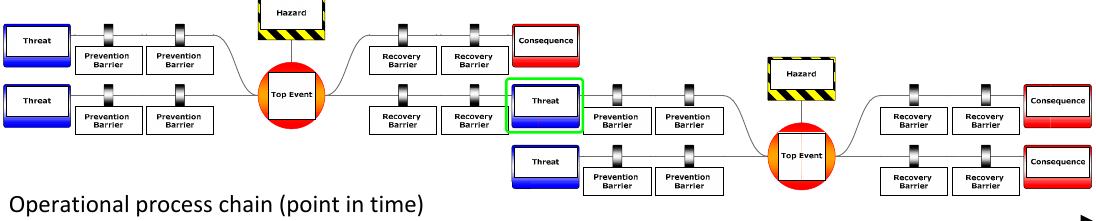
Figure 2. Generic Bowtie chain.